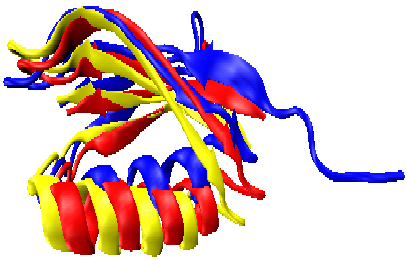
Figure 2. Cartoon representation of proteins 1P7E (yellow), 1IGD (blue) and 1P7F (red).